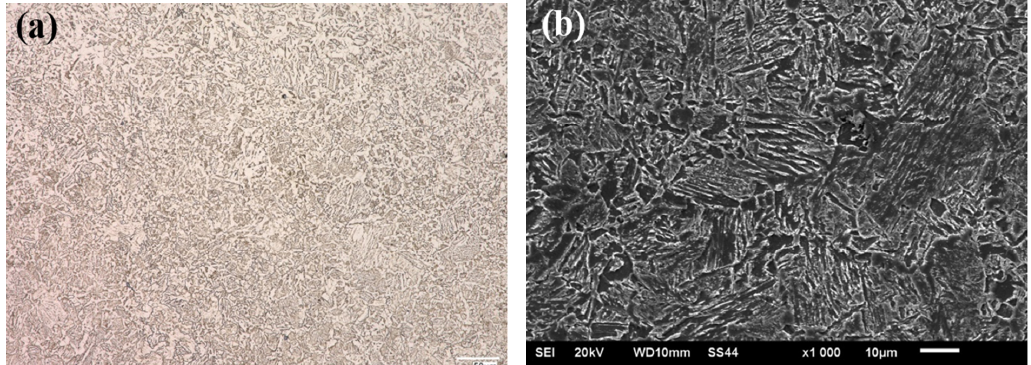
Figure 4. Microstructure of HTK 900H steel–base material of the test joint: ( a ) OM; ( b ) SEM.